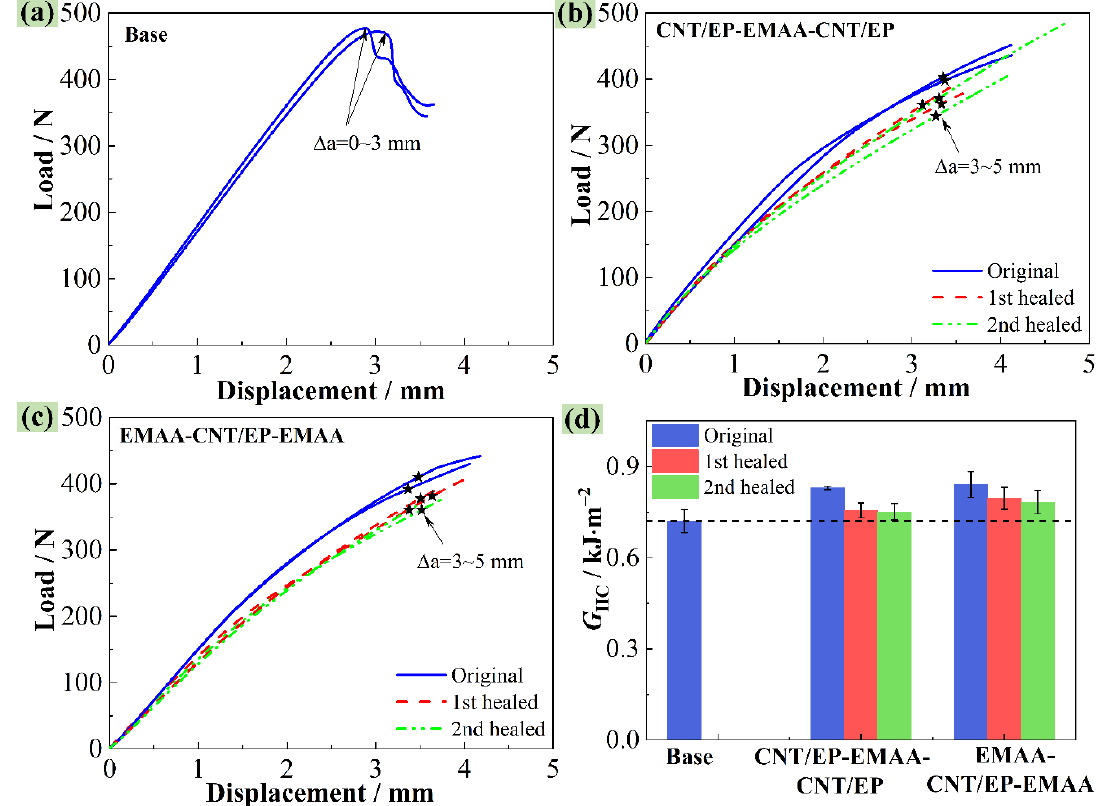
Figure 7. Mode II load–displacement curves from two delamination–healing cycles, ( a ) baseline CFRP, ( b ) CNT/EP-EMAA-CNT/EP CFRP, ( c ) EMAA-CNT/EP-EMAA CFRP, ( d ) comparison of G IIC